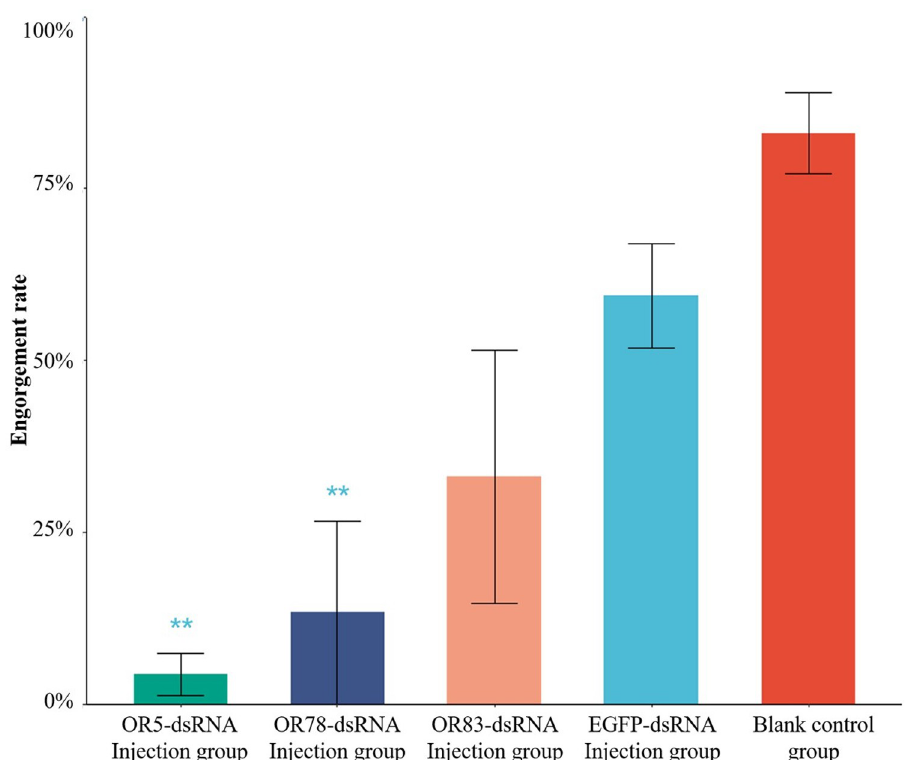
Fig 5. The blood-feeding rates of Cx . pipiens quinquefasciatus following the injections of different dsRNAs. The bar length indicates the standard deviation. chi-square test was used to compare the pairwise differences at the significance level of α = 0.05. Two asterisks ( �� ) represent p < 0.01, and one asterisk ( � ) represents p < 0.05 compared to the EGFP control. No difference was found between the EGFP control and blank control. OBP2 transcripts (CPIJ001365 and CPIJ007617) were jointly downregulated after blood feed-